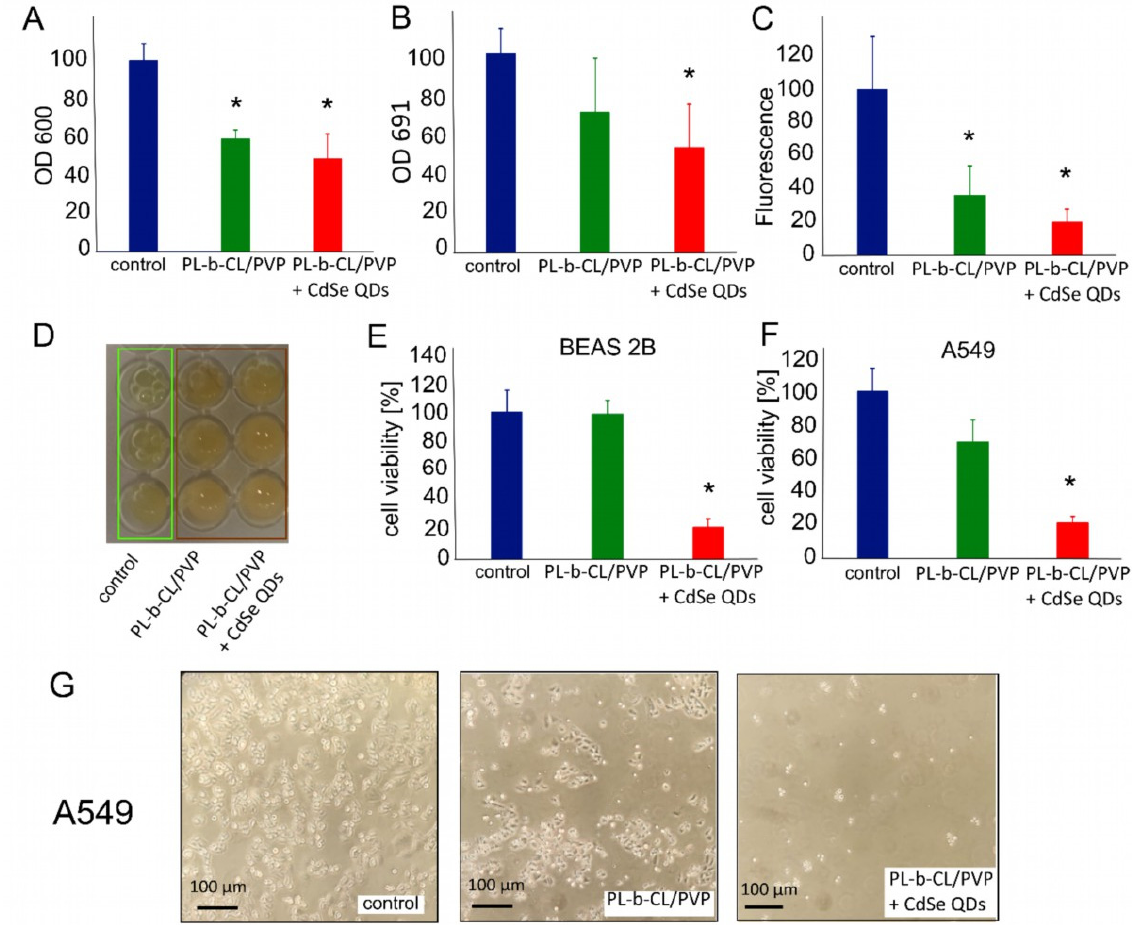
Figure 8. The biological properties of pristine and CdSe QDs-immobilized nano fi bers. The optical density of PAO1 measured at 600 nm ( A ). The pyocyanin level measured at 691 nm ( B ) and pyoverdine level fl uorescence measured at Ex/Em = 405/460 nm ( C ). The changes in the color of the bacterial culture media after treatment with nano fi bers, where green bracket indicates untreated bacteria and brown bracket indicates bacteria treated with nano fi bers ( D ). The cell viability of non-cancer BEAS-2 B cell line ( E ) and cancer cell line A549 ( F ) treated with nano fi bers. All results are expressed as the percentage, where 100% is a non-treated control. * indicates statistical signi fi cance ( p < 0.05). The cell growth inhibition of studied nano fi ber against A549 cells in optical microscopy (×64) ( G ).